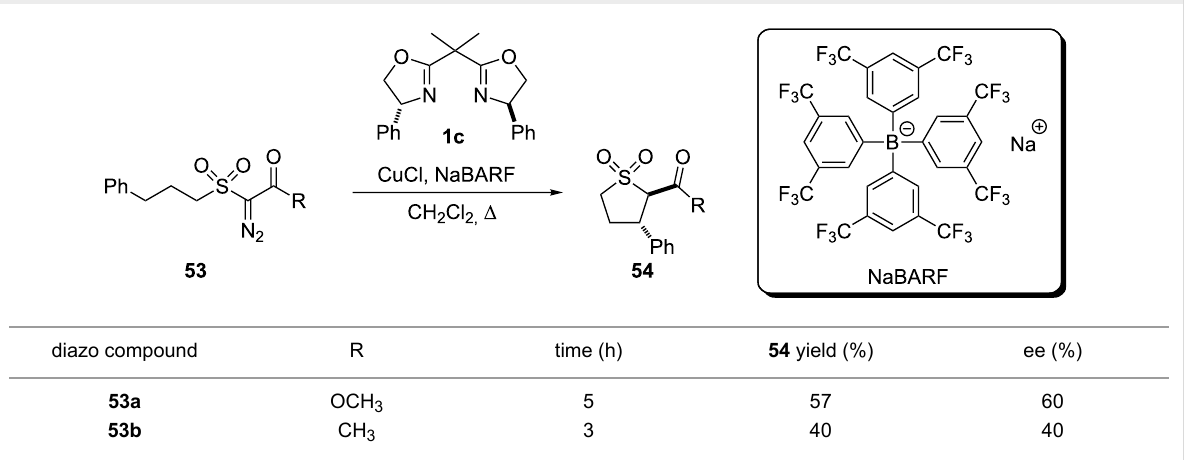
Table 6: Asymmetric insertion of copper carbenoids in C(sp 3 )–H bonds to prepare five-membered cyclic sulfones 54 .